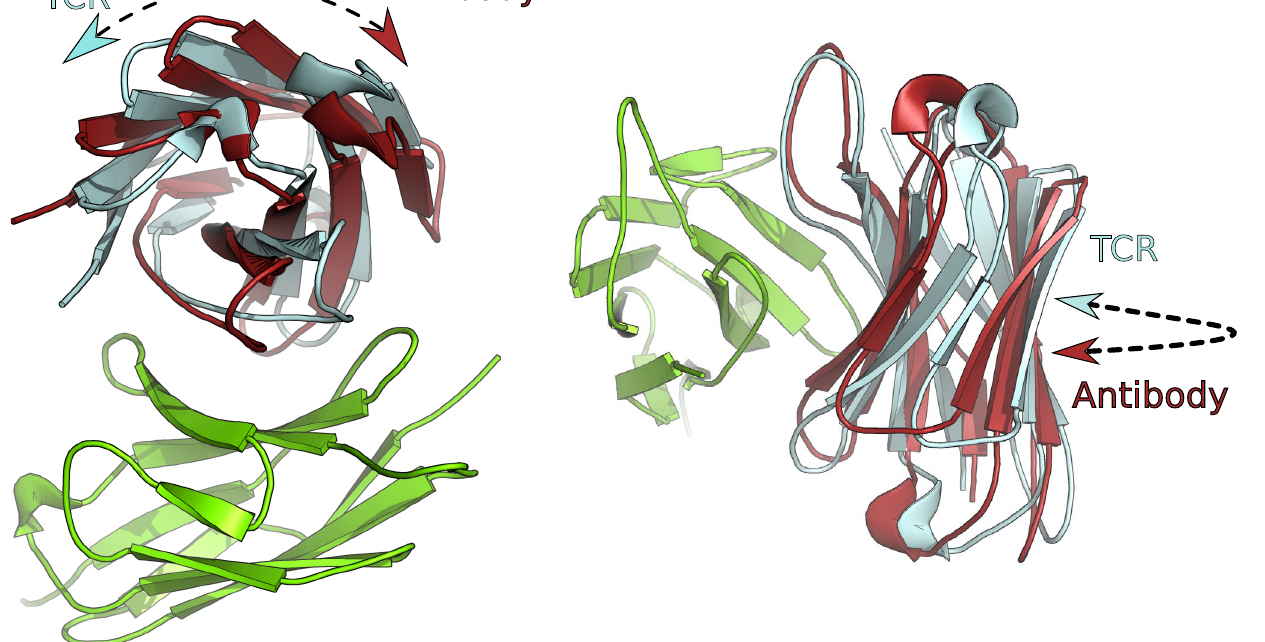
Figure 4. Two views showing the difference in variable domain orientation between antibodies and TCRs. The VH domain (red) and VL domain (green) of the antibody structure 3hzk is shown in its native orientation. The same antibody is also shown in the orientation assumed from the TCR structure 3qiu. In this case the VH domain is shown in cyan. The difference in variable domain orientation can be described as a twist of one domain with respect to the other and is best characterised using our HC2 twist angle.